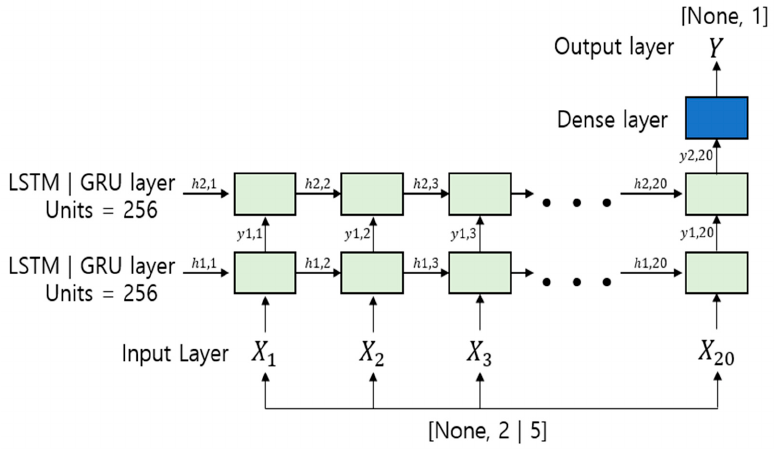
Figure 13. Construction of the proposed model.